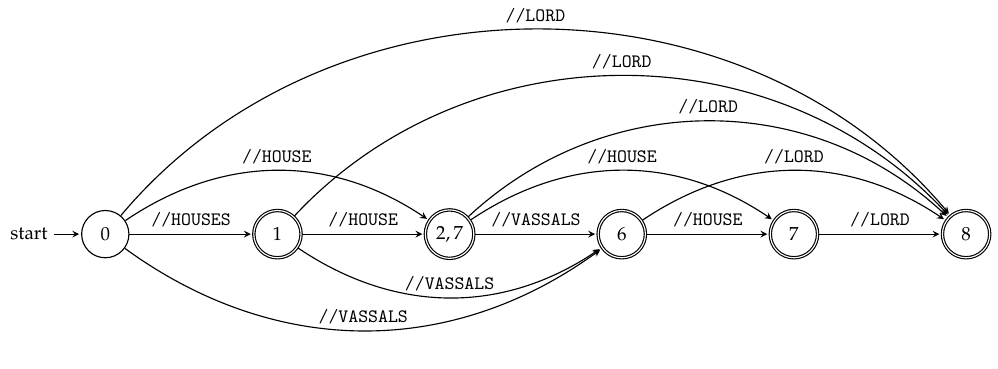
Figure 7. Deterministic subsequence automaton for the string path P = HOUSES ( 1 ) HOUSE ( 2 ) VASSALS ( 6 ) HOUSE ( 7 ) LORD ( 8 ) from Example 8.